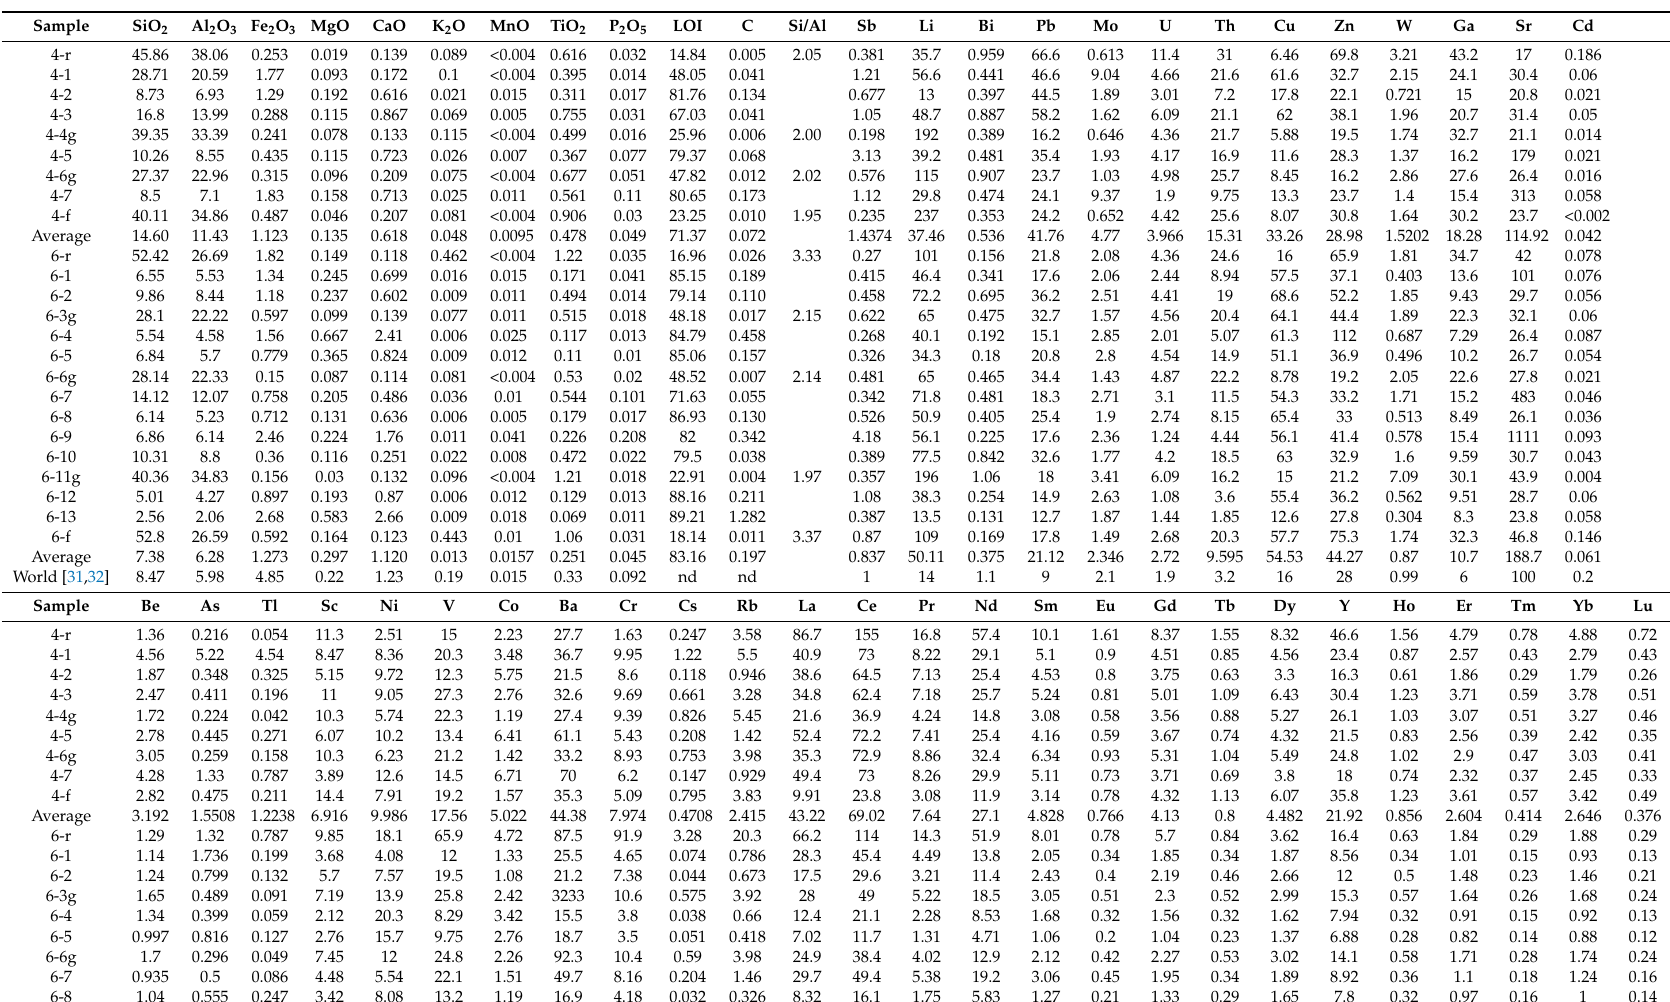
Table 2. The major and trace element contents in the No. 4 and No. 6 coal samples.